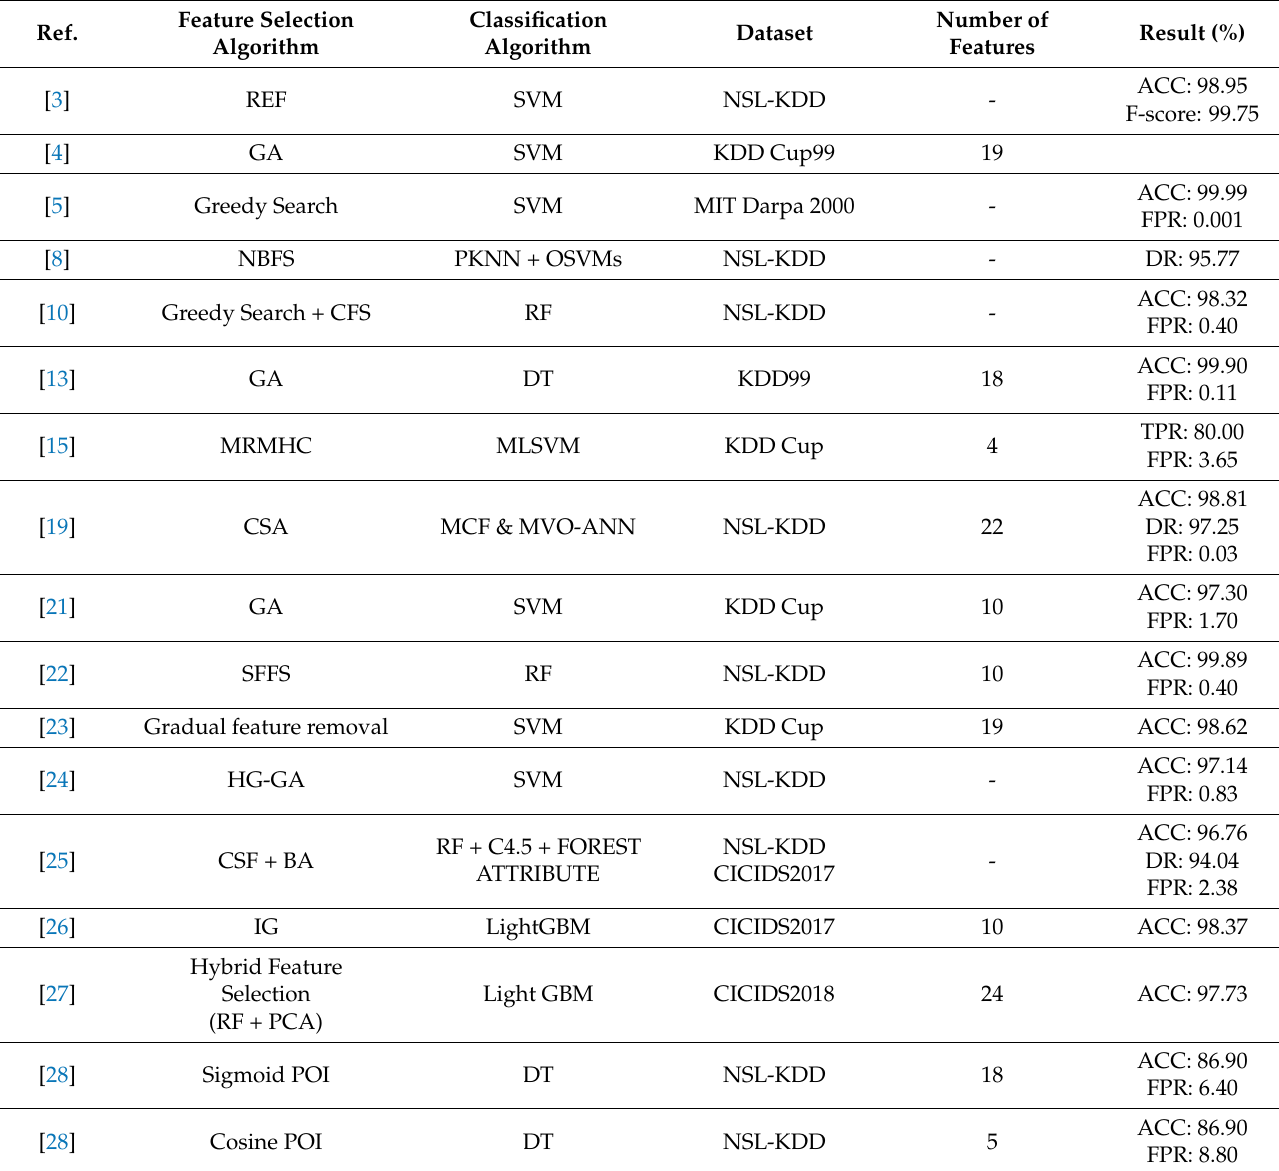
Table 1. Summary of the literature